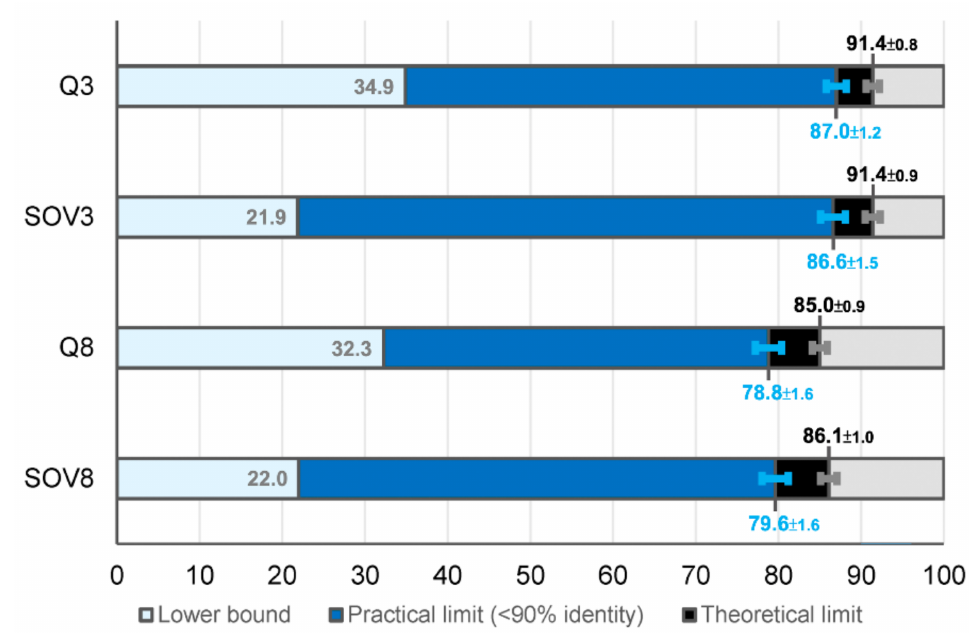
Figure 10. Summary of the estimated limits of SSP accuracy. Both the lower limits (light blue strips) and upper limits of three-/eight-state SSP accuracies are illustrated. The practical upper limits of accuracies (blue strips to the right) were estimated by PSI-BLAST sequence alignments with the word size 2 (see Figure 9 and Table S3), and the theoretical limits (black strips to the right) were estimated by structural alignments (Figure 3 and Table